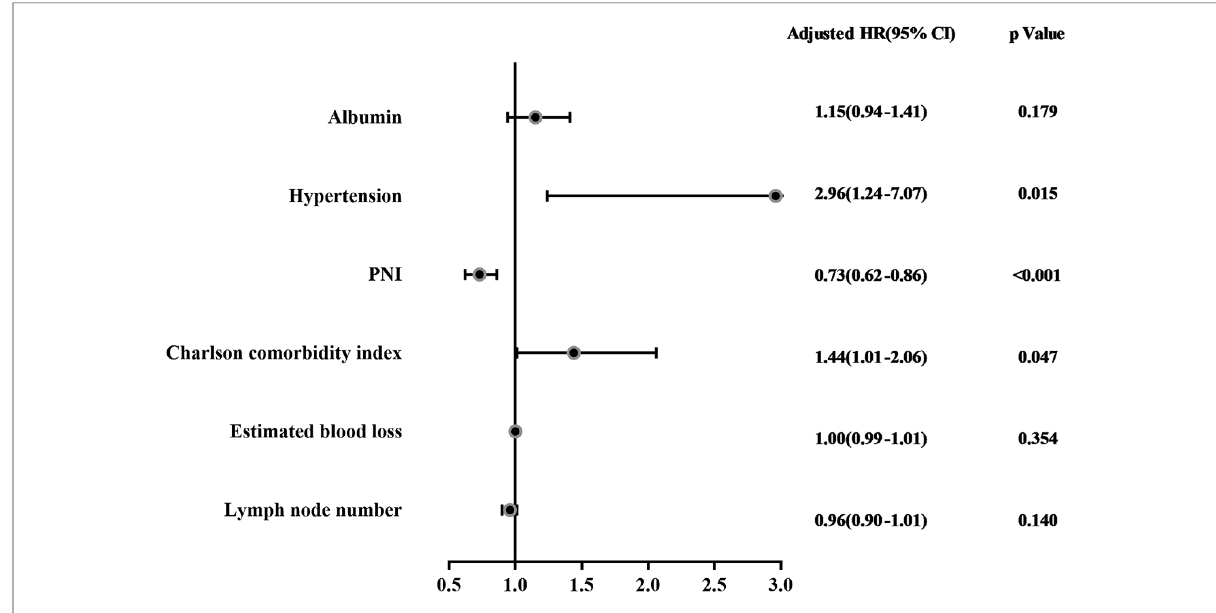
FIGURE 3 The forest plot of multivariate